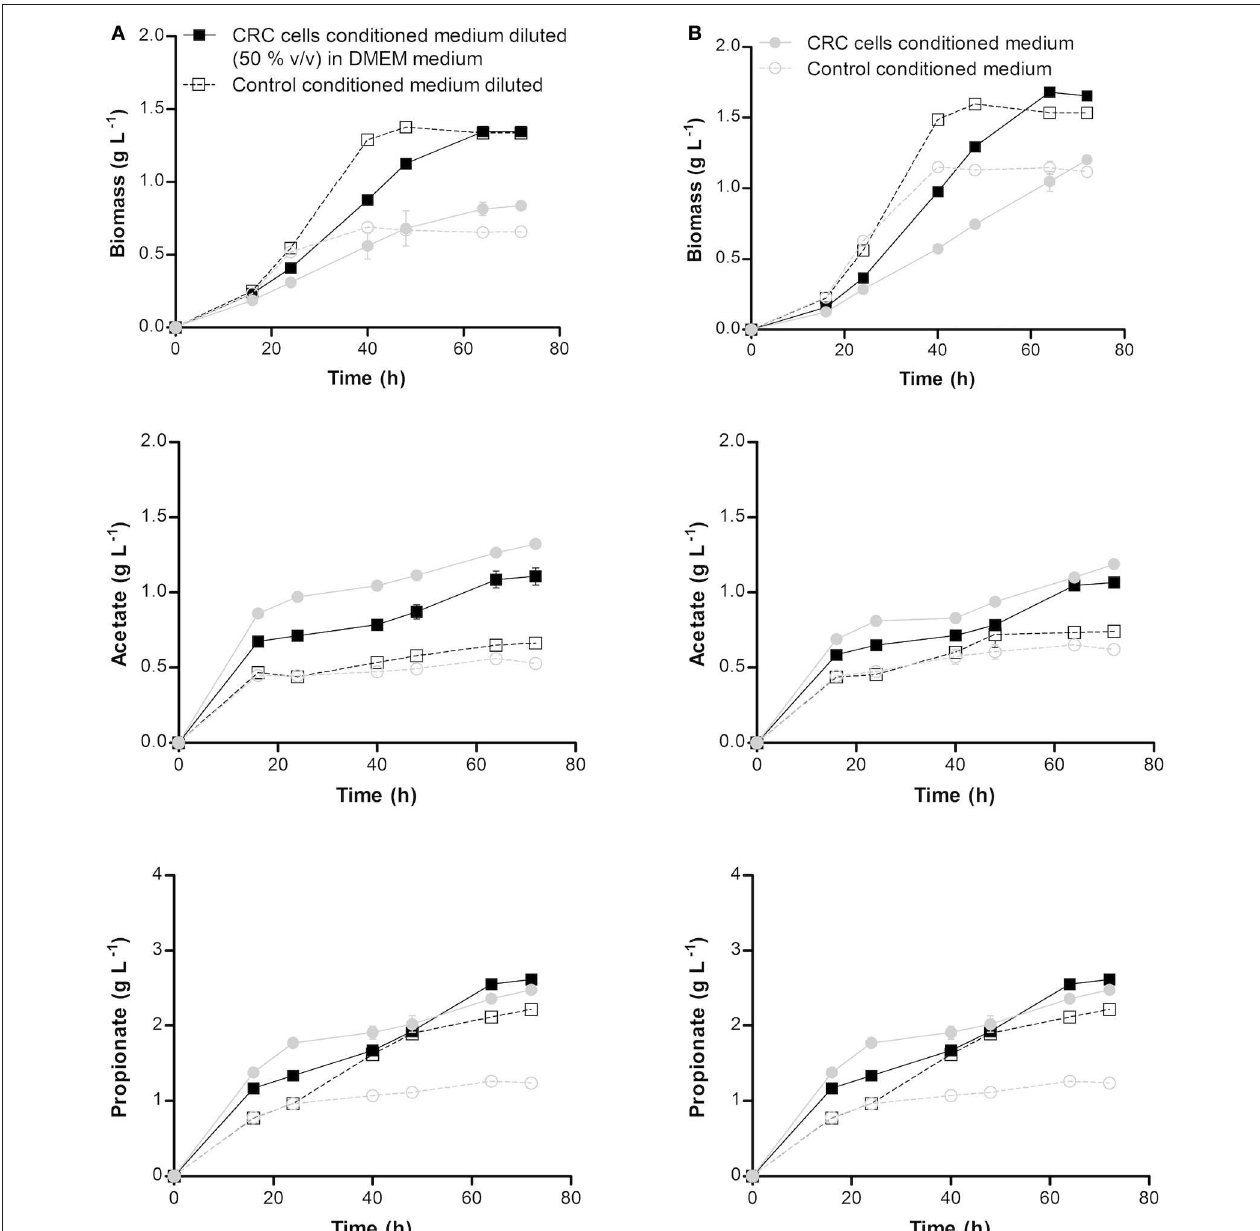
FIGURE 2 | Biomass, acetate and propionate production profiles by non-adapted (A) and adapted (B) Propionibacterium freudenreichii at pH 7.0 and 37 ◦ C in non-diluted and diluted [with fresh DMEM (1:1)] colorectal cancer cells conditioned medium and the respective controls. Conditioned medium consists in the supernatants collected after colorectal cancer cells growth in a DMEM medium without antibiotic for 72h at 37 ◦ C in a humidified incubator with 5% CO 2 . Each condition was run in duplicate and the results are represented by the mean ± standard error of the